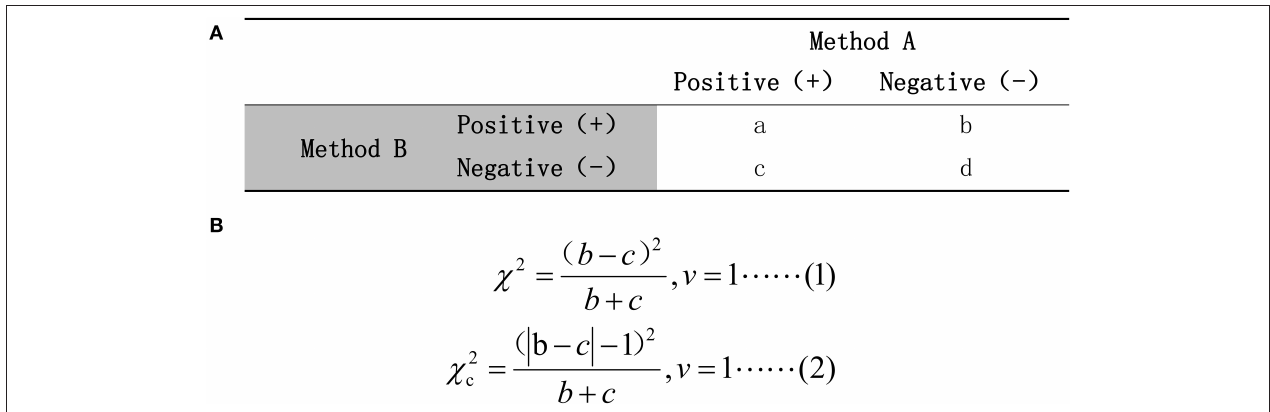
FIGURE 6 | (A) The mechanism of McNemar’s test. (B) The calculation formula for χ 2 -value. Formula (1) would be used if ( b + c ) ≥ 40; otherwise, formula (2) should be chosen.